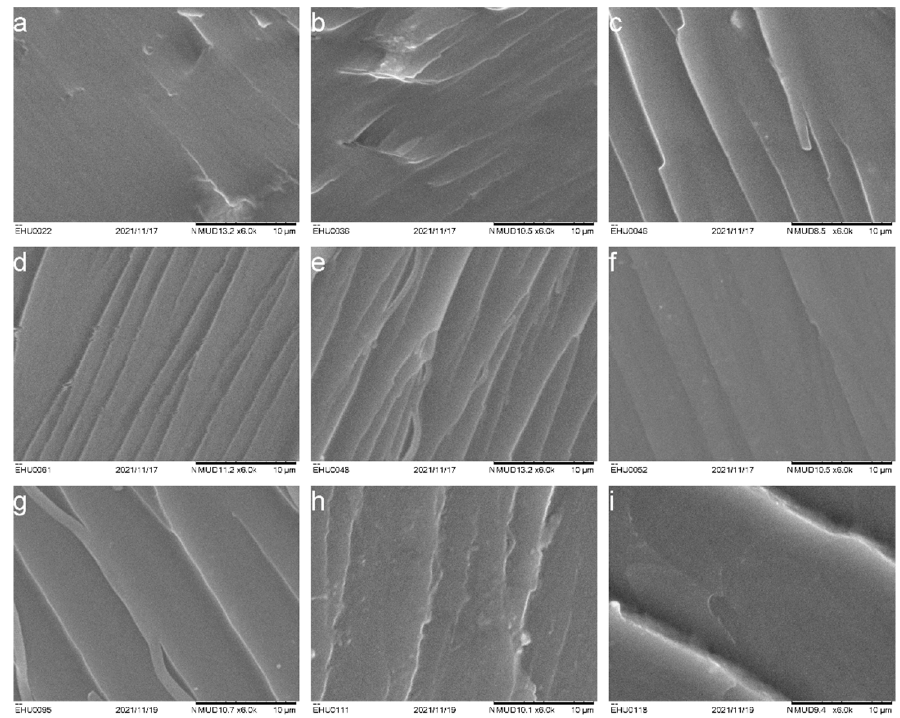
Figure 4. SEM micrographs of cryogenically broken specimens with different PCL contents: ( a ) 90/10 IL-P-TMPP, ( b ) 80/20 IL-P-TMPP, ( c ) 70/30 IL-P-TMPP, ( d ) 90/10 IL-P-DCA, ( e ) 80/20 IL-P-DCA, ( f ) 70/30 IL-P-DCA, ( g ) 90/10 IL-I-DCA, ( h ) 80/20 IL-I-DCA, and ( i ) 70/30 IL-I-DCA.